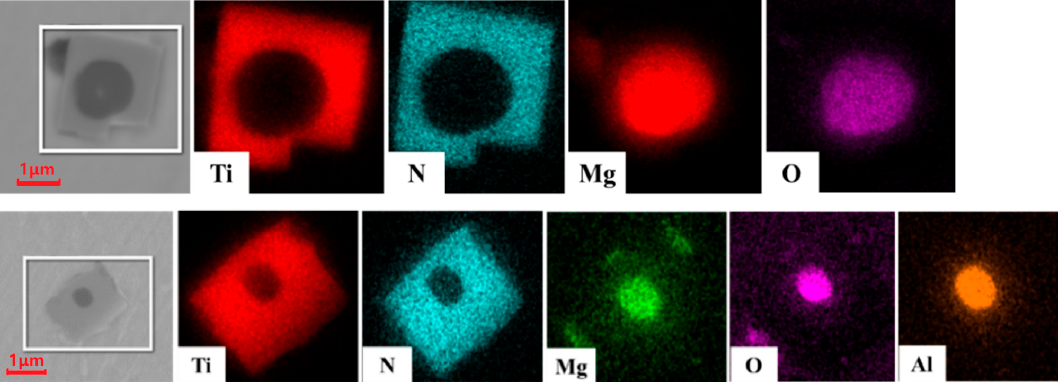
Figure 13. Appearance of TiN particles in specimens after magnesium